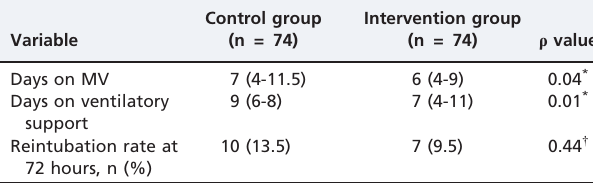
Table 2 - Primary outcomes.